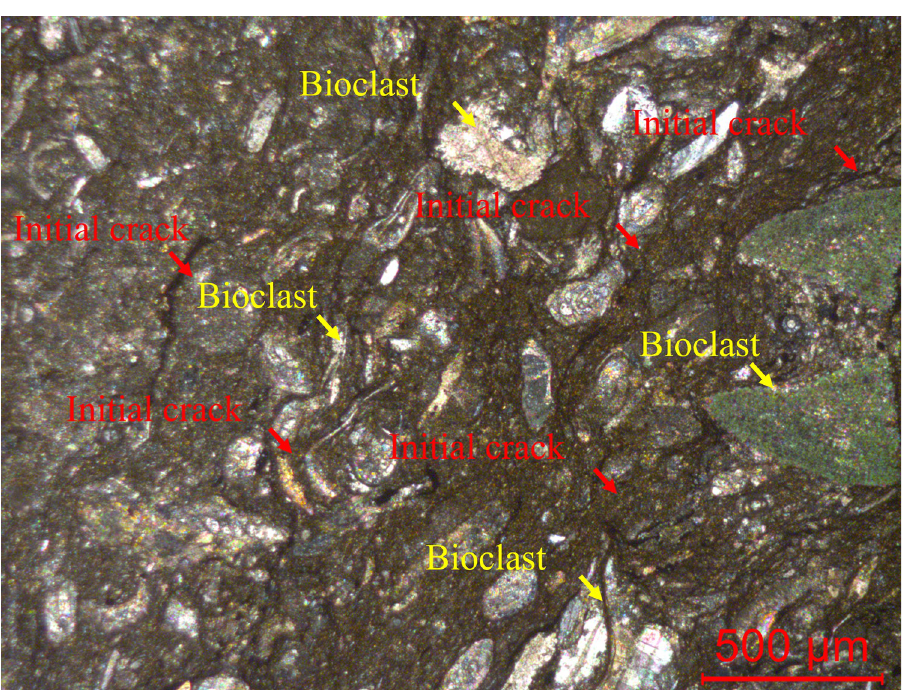
Fig 2. Micritic bioclastic limestone composition, as observed under a polarizing